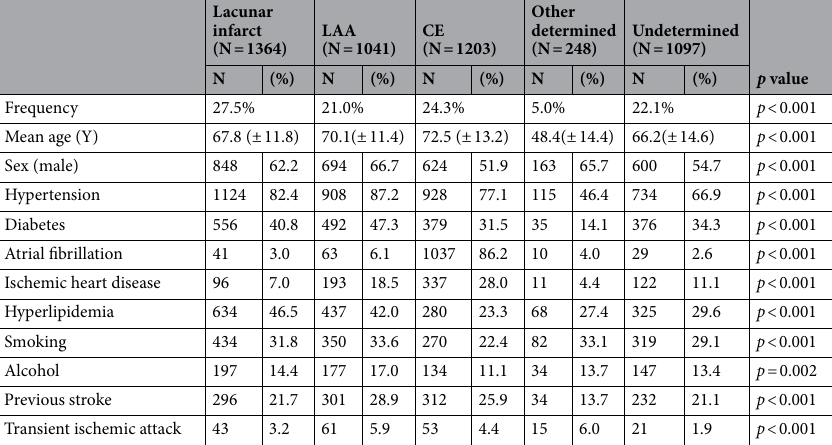
Lacunar infarct (N =